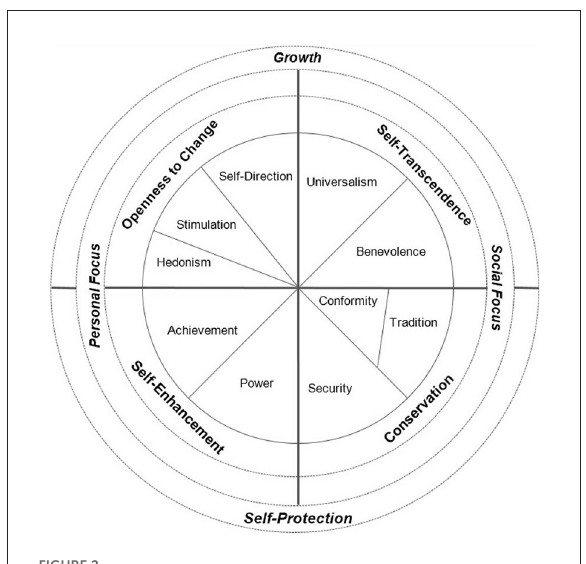
FIGURE2 Schwartz’s basic human values. Source: Magun et al.